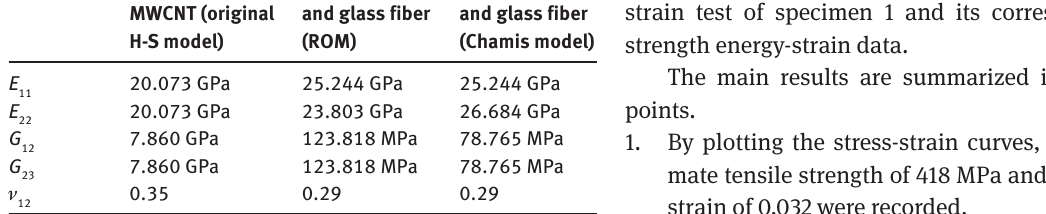
Table 2: Mechanical properties of reinforced resin and GFRPNC.